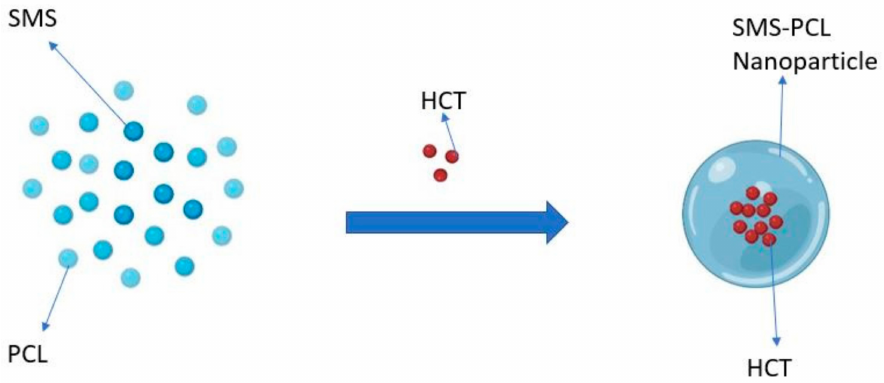
Figure 1. Illustration of the microemulsion method. The figure demonstrates loading of HCT into a micellar structure (SMS-PCL nanoparticle) for loading into the hydrogel (image was completely re-drawn, inspired by Güngör et al.